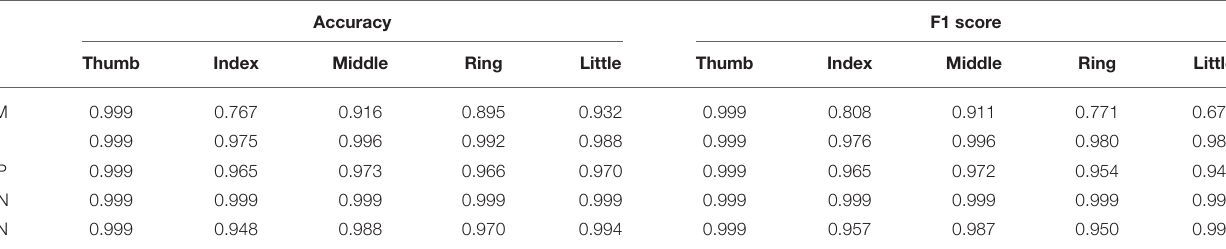
TABLE 3 | Classification